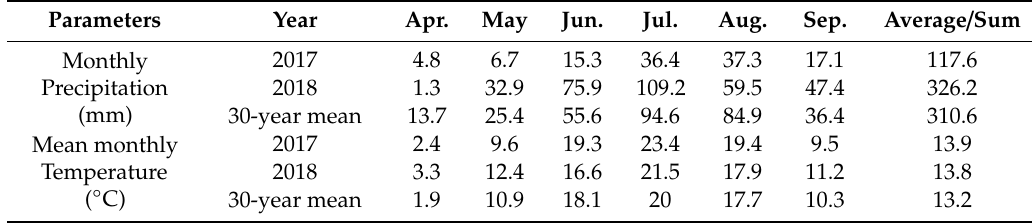
Table 3. Precipitation and monthly mean temperature in Xieertala